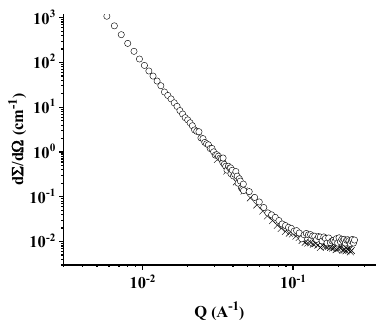
Figure 3. Nuclear SANS cross-sections for Eurofer97 un-irradiated reference sample from Figure3. NuclearSANScross-sectionsforEurofer97un-irradiatedreferencesamplefromReferences[10] (crosses) and [14] (empty circles). References [10] (crosses) and [14] (empty circles).